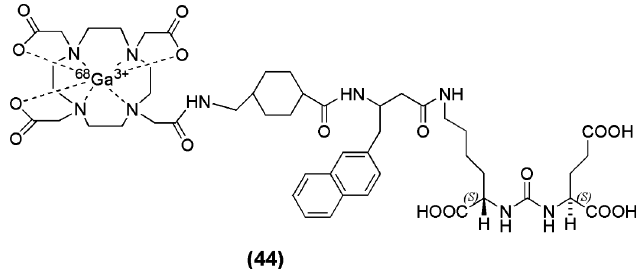
Figure 13. Chemical structure of 68 Ga-PSMA-617 ( 44 ) [133].